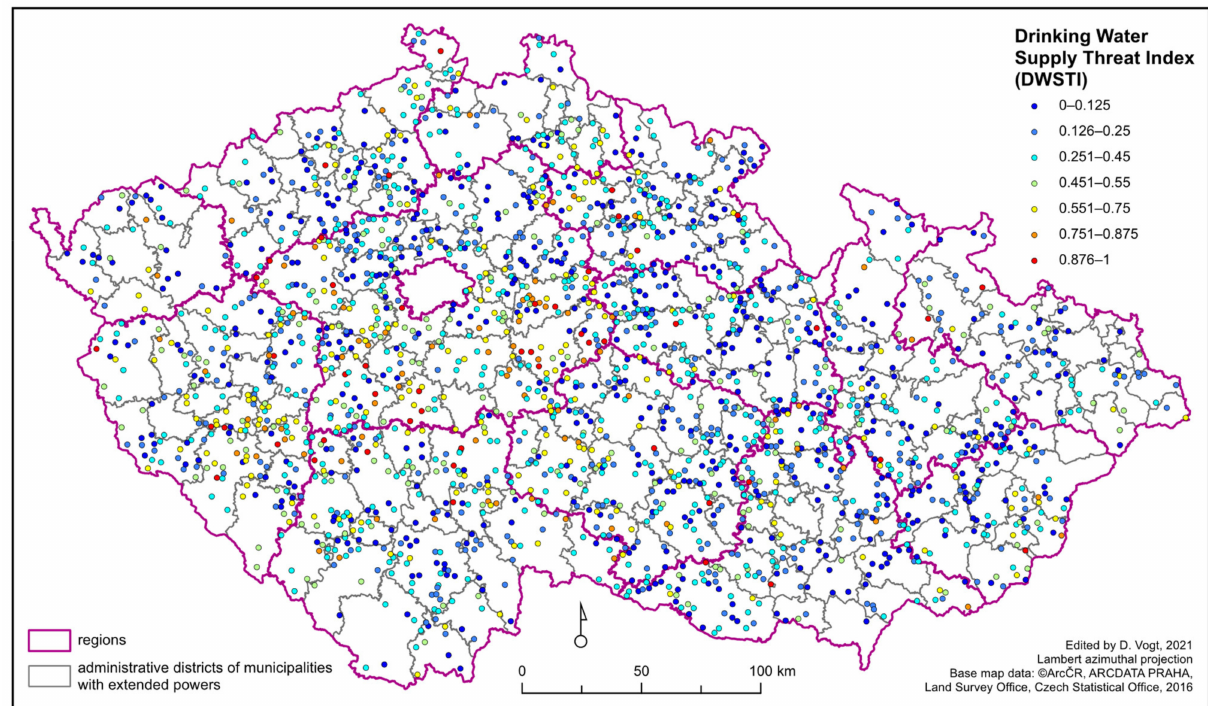
Figure 6. Assessment of Czech municipalities with less than 2000 inhabitants (involved in the survey n = 2110) according to the Drinking Water Supply Threat Index (DWSTI). Source: own processing based on questionnaire survey and data